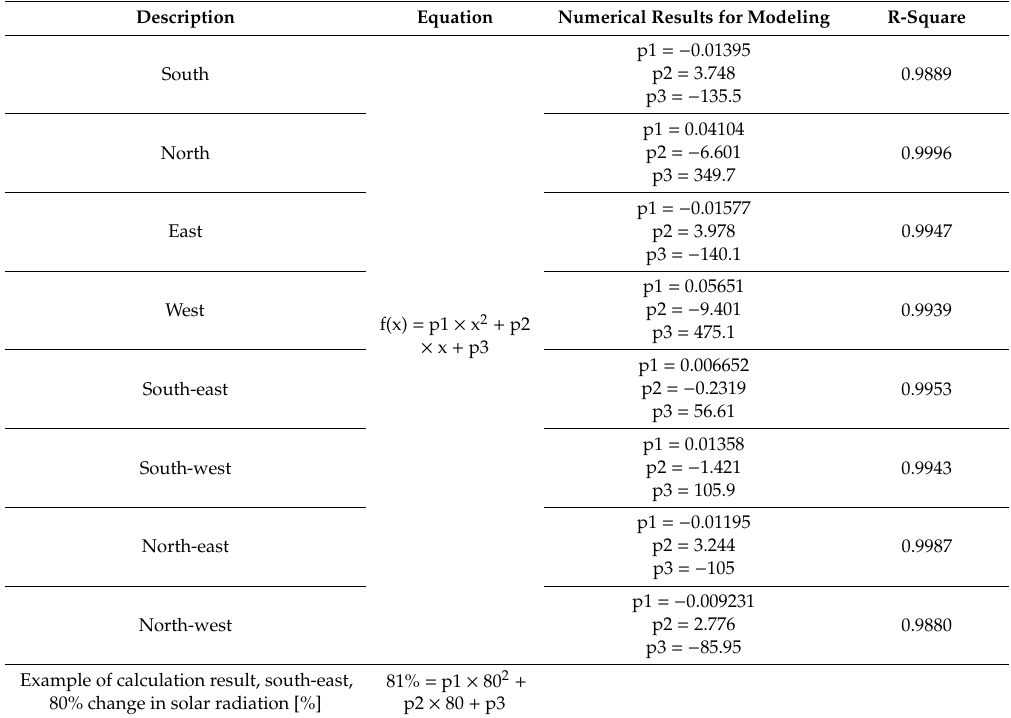
Table 3. The e ff ect of solar radiation changes on m-Si performance. (x = change in solar radiation (%), FP = 100%, 80% = 20% change in solar radiation; f(x) = percentage value of the performance compared to the FP).